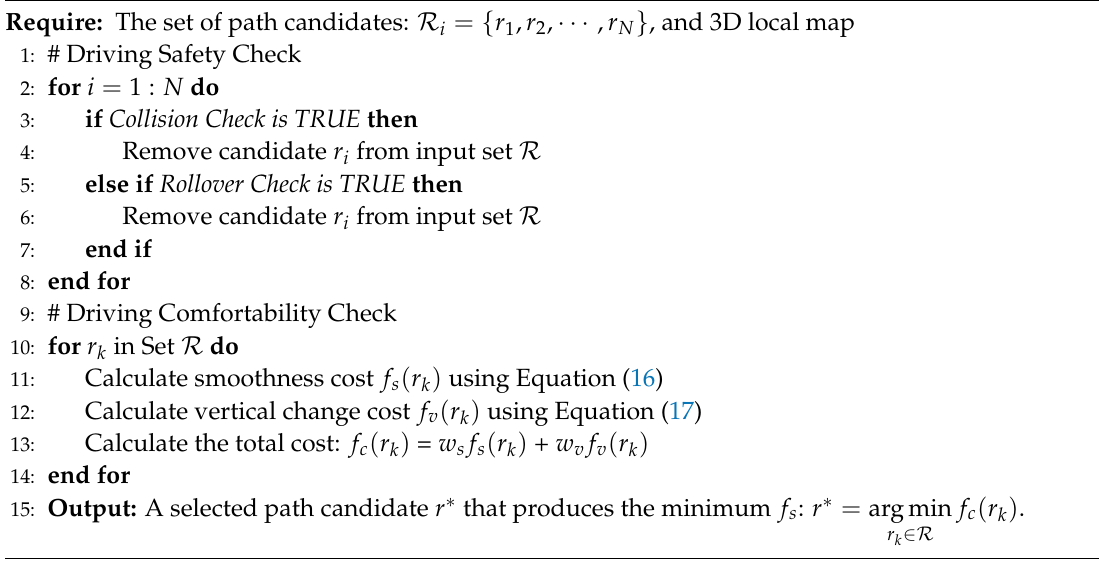
Algorithm 1 Path candidate selection algorithm for off-road autonomous